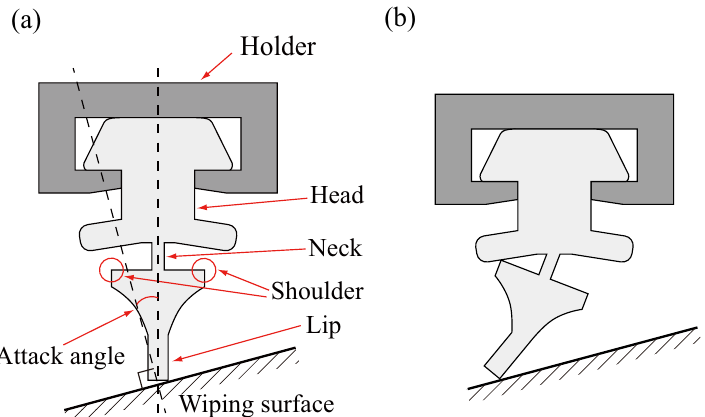
Figure 1. Cross-section of wiper system with attack angle. ( a ) Shoulder stays away from the head; ( b ) shoulder contacts the